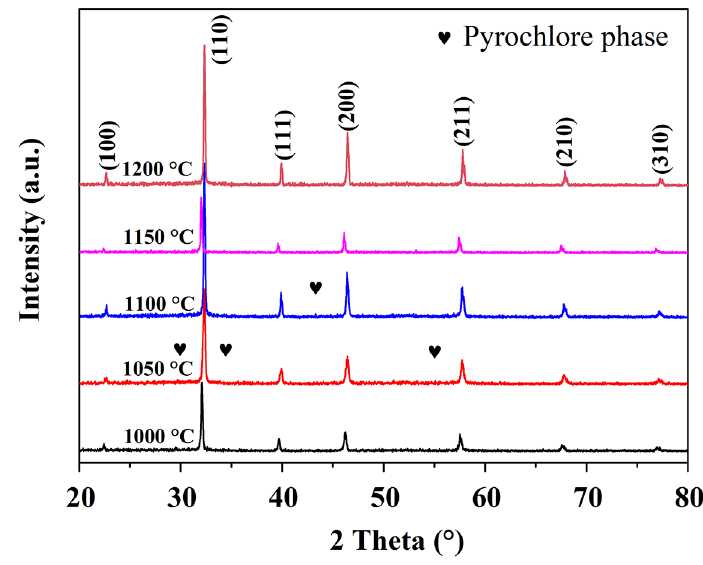
Figure 2. X-ray diffraction patterns of NBT-BT-NN ceramics in a wide range from 20 ° to 70 °.